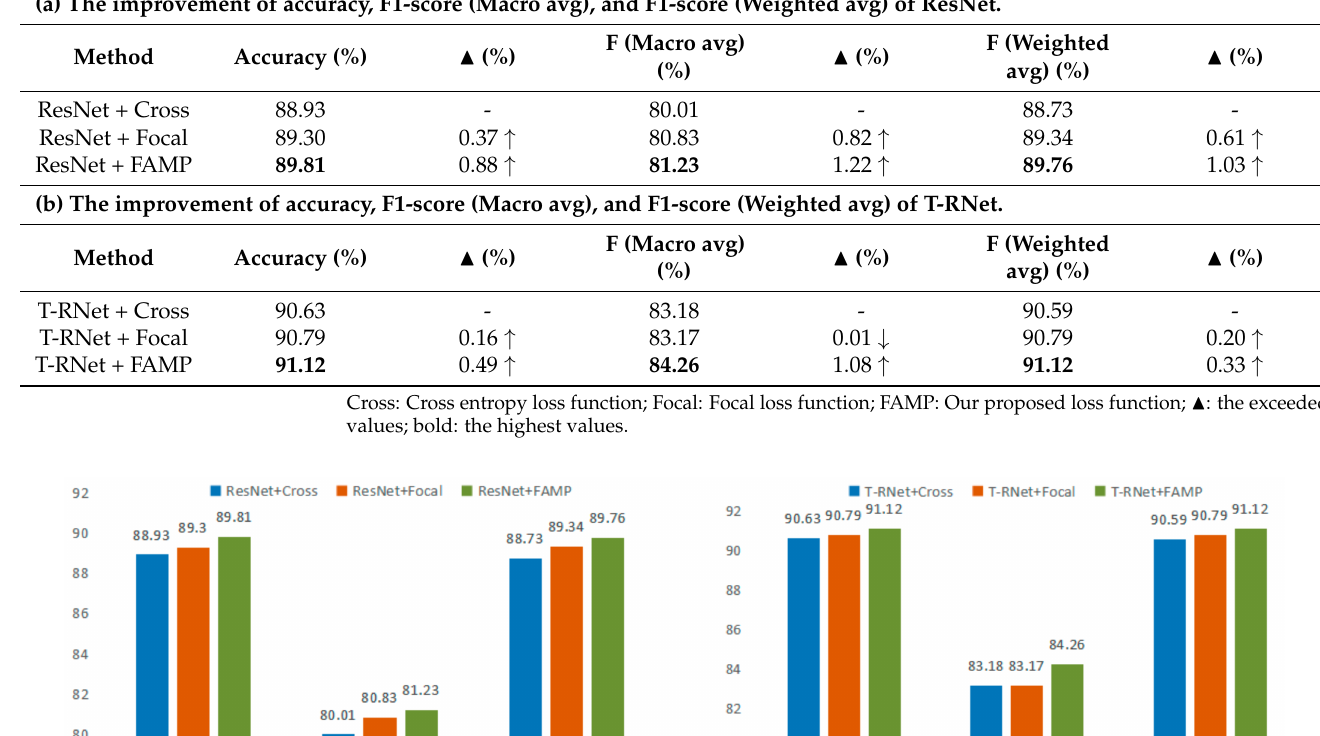
Table 5. Performances of different loss functions on ResNet and T-RNet.